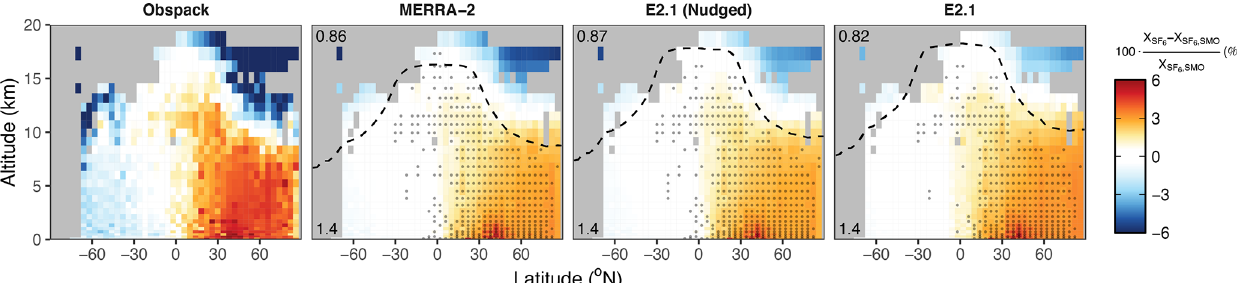
Figure 9. Lower atmospheric gradients of SF 6 shown as zonal mean percent difference with respect to Cape Matatula, American Samoa (SMO; 14.2 ◦ S, 170.6 ◦ W; 42ma.s.l.), for 2005–2014CE. The left panel shows observed values from version 2.1.1 of the NOAA SF 6 ObsPack aggregated at E2.1 vertical resolution. The three panels on the right show the values from the model driven by the three meteorology products sampled at each observation month and location. Gray dots indicate locations where the simulated gradient is statistically different from the observations with respect to interannual variability ( p value < 0.05; n = 10 years). The number in each model panel’s top left shows the pattern correlation ( R ) of that simulation to the observations. The lower left number shows the mean absolute percent bias of each simulation relative to the observations. The dashed black line shows each simulation’s climatological zonal mean tropopause height.